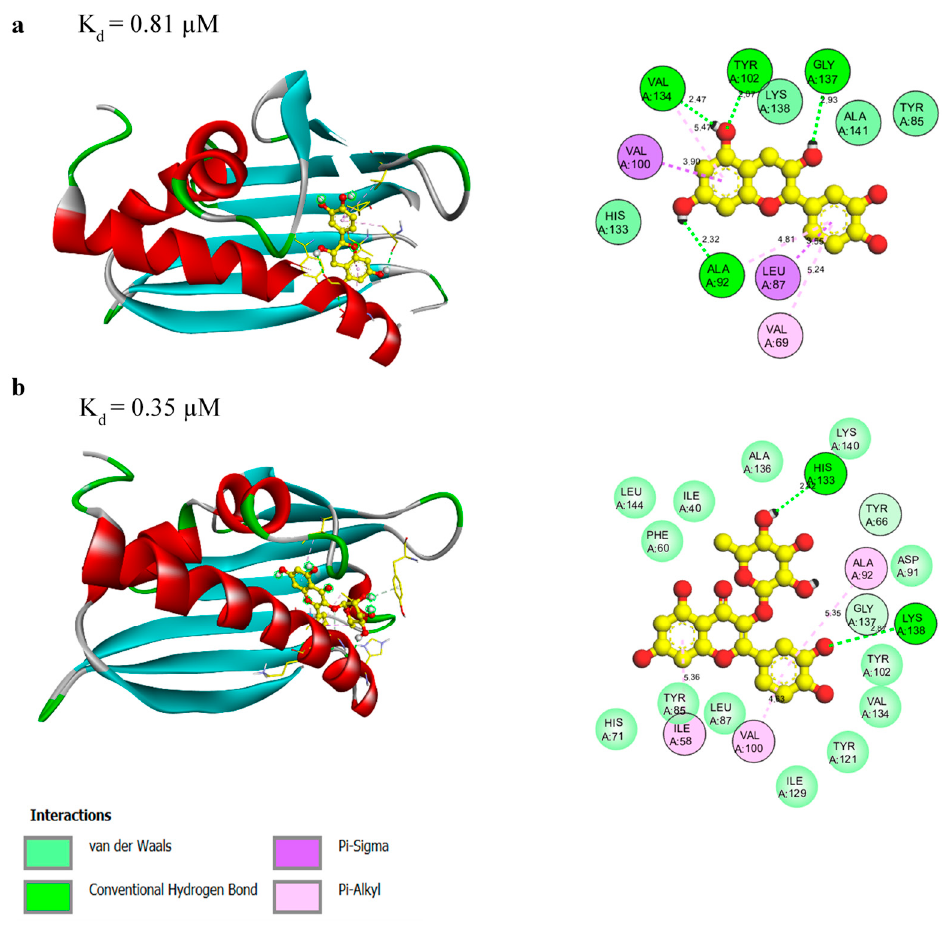
Figure 2. 3D ( left ) and 2D ( right ) interaction models of rMal d 1 in complex with (+)-catechin ( a ) and quercetin-3- O -rhamnoside ( b ).